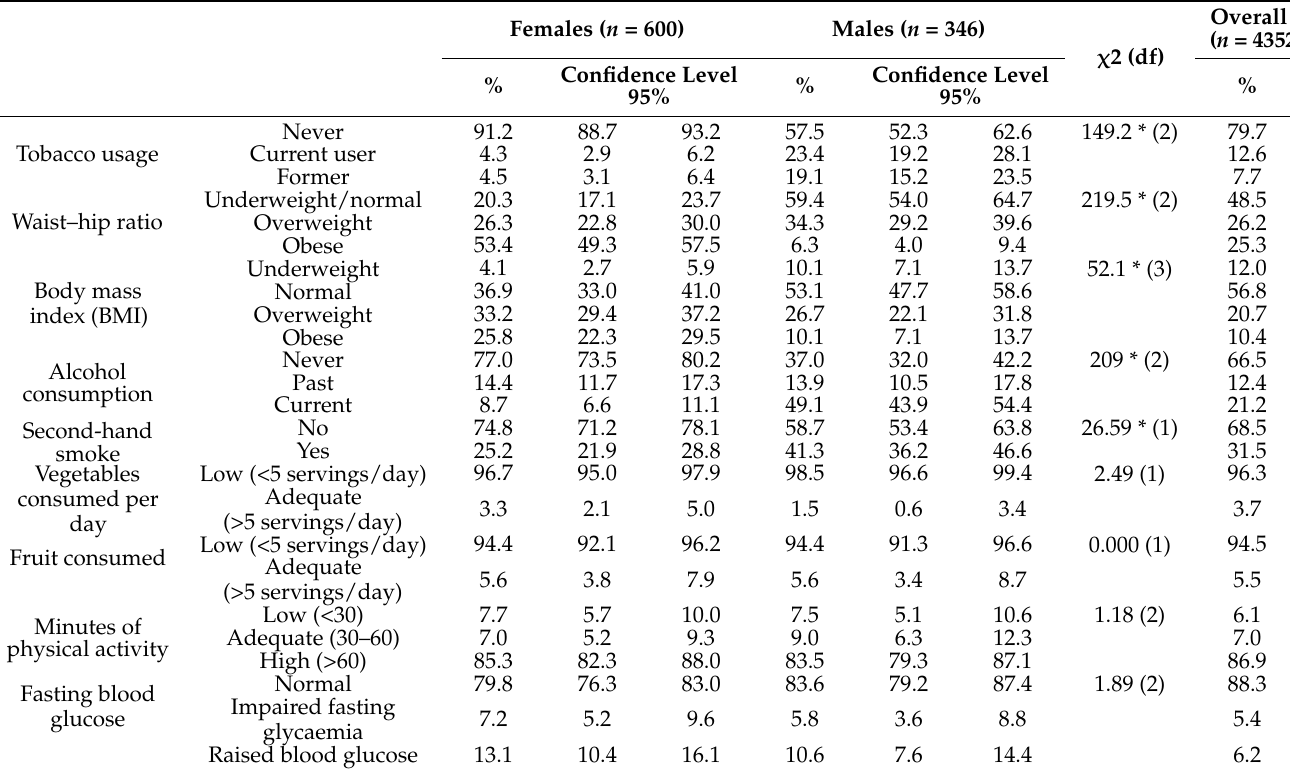
Table 3. Risk factors in the full sample and people with hypertension by